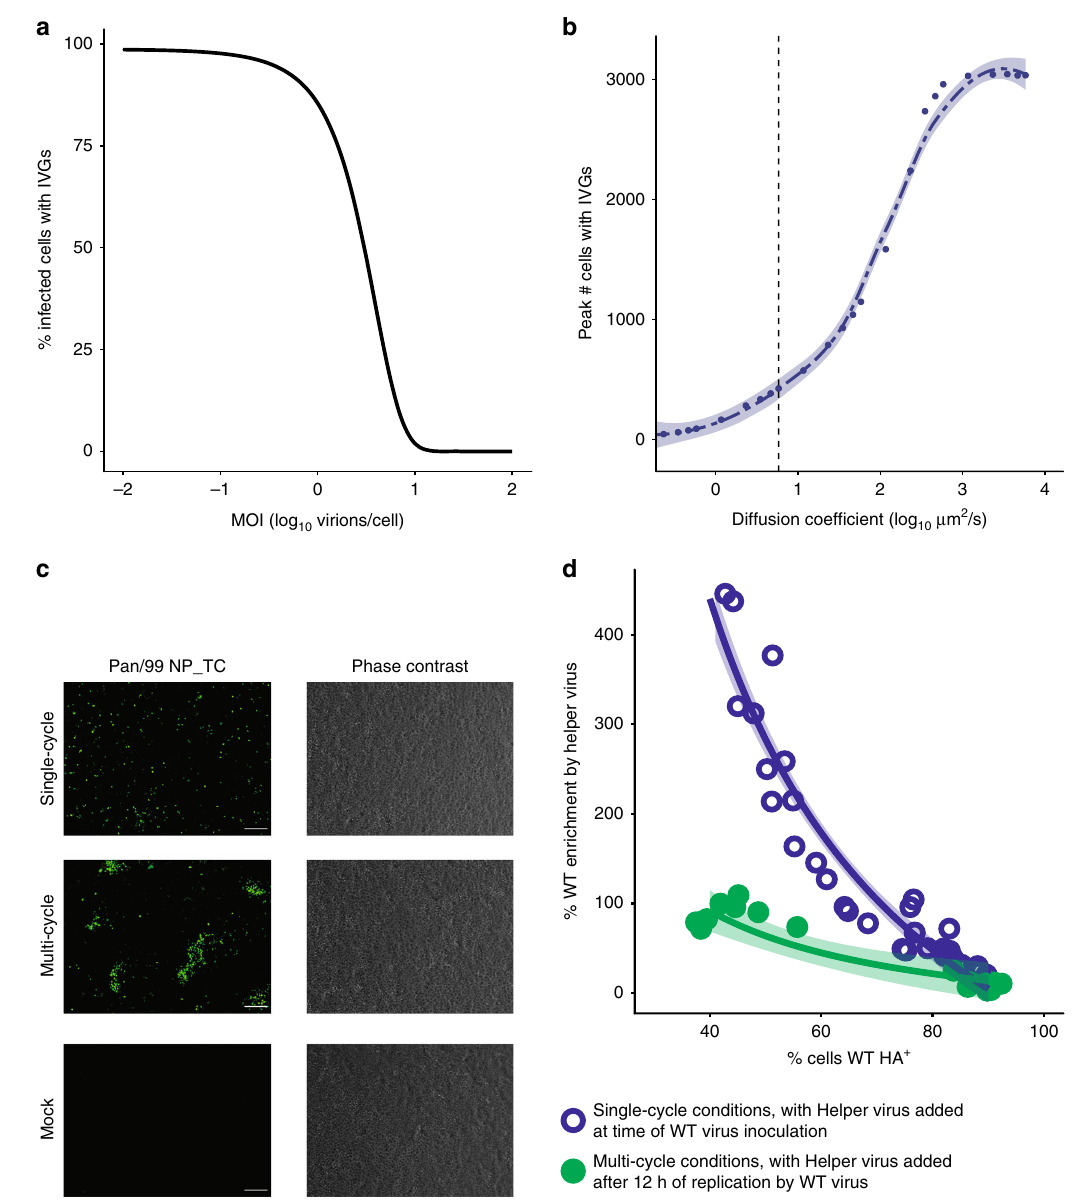
Fig. 6 Complementation of incomplete genomes occurs ef fi ciently at high MOI and during secondary spread from low MOI. a The model shown in Fig. 3 was used to calculate the probability that a given infected cell contained an IVG. The percentage of infected cells that contain fewer than eight segments is shown at a range of MOIs for P P = 0.58. b An infection in which multi-cycle replication occurs with the spatial structure was simulated as in Fig. 4. The maximum number of cells that contain IVGs in each simulation is shown for a range of diffusion coef fi cients. Shading represents 95% CI of local regression (mean ± 1.96 * SE). c Visualization of spatially structured and unstructured infections. Cells were inoculated with Pan/99-NP_TC virus and incubated under single-cycle conditions for 12 h (top), multi-cycle conditions for 12 h followed by single-cycle conditions for 12 h (middle), or sham-inoculated and incubated under single-cycle conditions for 12 h (bottom), then visualized by FlaSH staining (left) or phase-contrast imaging (right). Scale bar represents 200 µ m. d The extent to which the presence of Pan/99-Helper virus increased WT HA positivity (% enrichment) was evaluated at the outset of infection (open blue circles) and following secondary spread ( fi lled green circles). To gauge potential for complementation at the outset of infection, cells were simultaneously inoculated with Pan/99-WT virus and Pan/99-Helper, then incubated under single-cycle conditions for 12 h ( N = 3 replicates per MOI, four MOIs per experiment, and three independent experiments). To test the impact of secondary spread on potential for complementation, cells were inoculated with Pan/99-WT virus at low MOI and incubated under multi-cycle conditions for 12 h, then inoculated with Pan/99-Helper virus and incubated under single-cycle conditions for 12 h ( N = 3 replicates per MOI, two MOIs per experiment, and three independent experiments). Curves represent Multi (cid:2) cycle þ β þ β (cid:3) (cid:2) cycle , with shading representing 95% CI (mean ± 1 estimates of a fi xed effects model with the formula % Enrichment ¼ β % WTHA þ % WTHA þ 1 2 3 Multi 1.96 * SE) of model estimate. IVGs = incomplete viral genomes. Source data are provided as a Source Data fi Helper viruses, and (iii) infections where Helper virus was added 12 h after low MOI WT virus. If superinfection exclusion was limiting the ability of Pan/99-Helper virus to complement IVGs among cells, we would expect lower frequencies of Helper HA